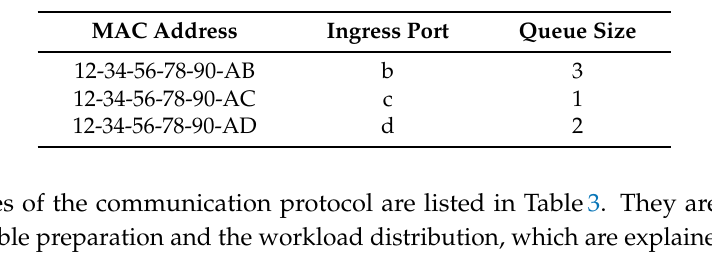
Table 2. Extended MAC table.